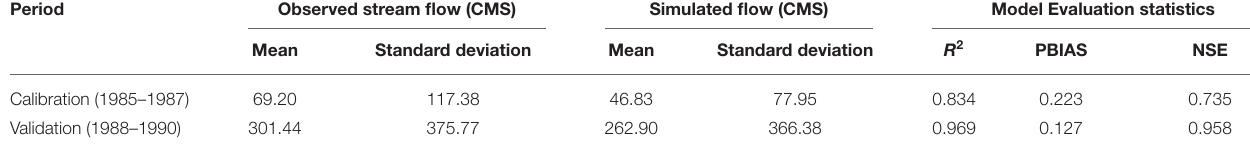
TABLE 3 | Statistics of observed and simulated stream flows for the calibration and validation periods.